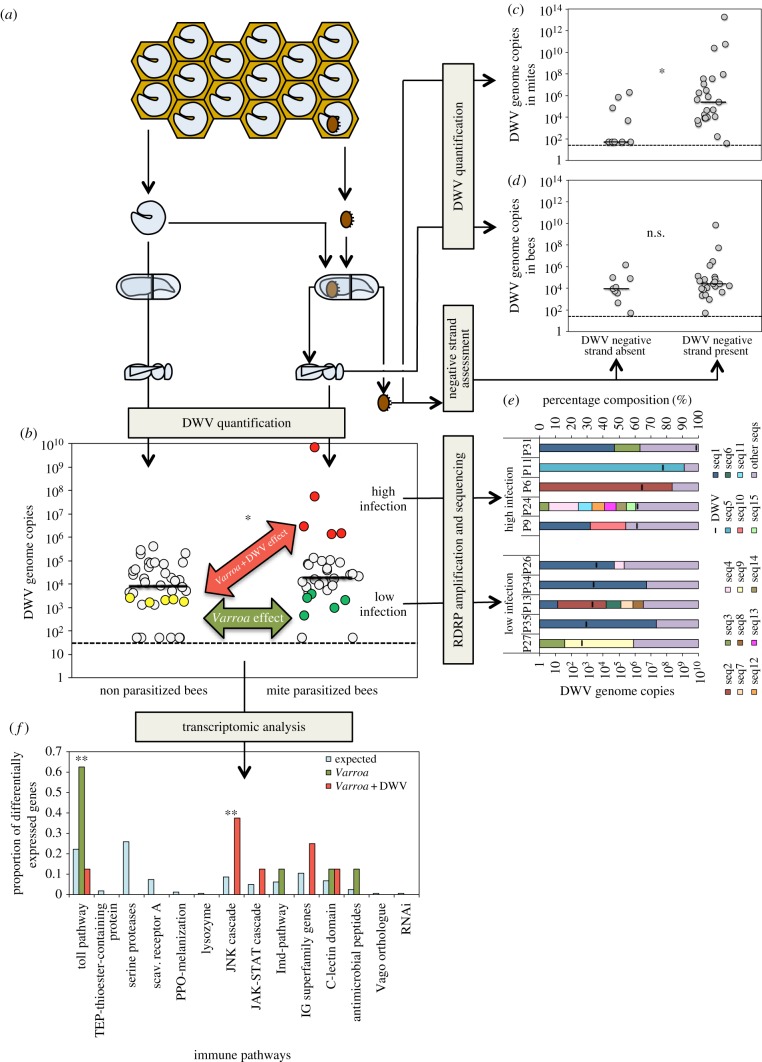
Evaluation of existing hypotheses about the role of Varroa mite in increasing virulence of DWV: methods and results. (a) Individual bees naturally infected with DWV were artificially infested with one Varroa mite or left uninfested. (b) Viral load in individual bees infested with one mite or left uninfested as a control. In this and following similar figures, the dashed line represents the lower detection limit for the methodology used; the solid lines represent the median viral load. The samples used for the transcriptomic analysis are marked with different colours: yellow (uninfested-low virus infected bees), green (mite-infested-low virus infected bees) and red (mite-infested-high virus infected bees). An asterisk marks a significant difference at p < 0.05. (c) DWV genome copies in Varroa mites where an active replication was detected (DWV negative strand present) or not (DWV negative strand absent). An asterisk marks a significant difference at p < 0.05. (d) DWV genome copies in bees infested by mites where an active replication was detected (DWV negative strand present) or not (DWV negative strand absent). (e) Prevalence of different DWV variants in infected bees with variable virus infection levels. The thick vertical lines represent DWV genome copies observed in each sample. (f) Effect of the Varroa mite and the combination Varroa-DWV on the expression of genes of the canonical immune pathways. The proportion of differentially expressed genes in each pathway, as resulting from the comparison: uninfested-low viral infected bees versus mite-infested-low viral infected bees (i.e. Varroa effect) and from the comparison: uninfested-low viral infected bees versus mite-infested-high viral infected bees (i.e. Varroa + DWV effect), is reported as well as the proportion of immune genes belonging to that pathway (i.e. expected). Two asterisks mark significant differences at p < 0.01 between expected and observed proportions.